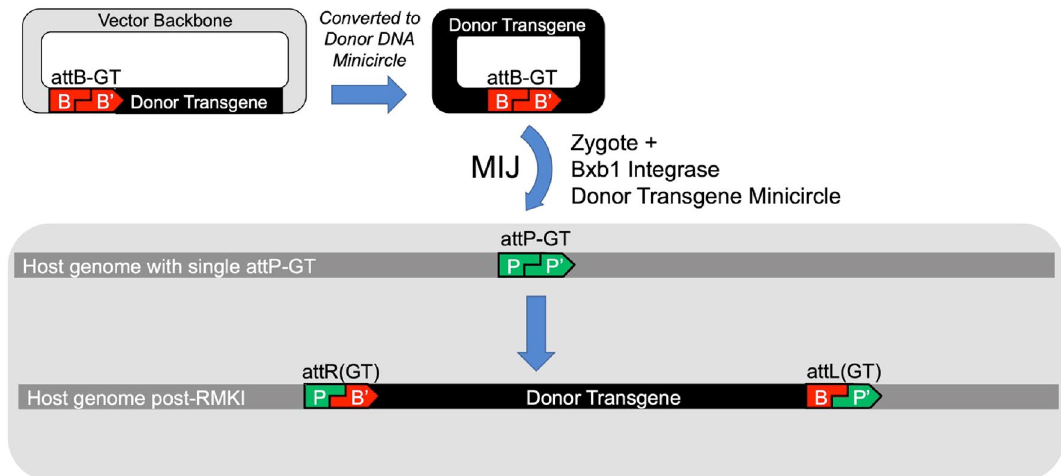
Figure 3. Schema for using single attP-GT site mouse strains targeted by RMKI. Before microinjection, the plasmid vector containing the donor transgene and a single cognate attB-GT site are converted into (vector- less) DNA minicircles and purified. Along with Bxb1 Int, the minicircles are delivered into zygotes carrying the attP-GT landing pad allele, enabling precision transgene integration as the attP (host genome), and attB (donor DNA) sites recombine to form attR and attL sites.